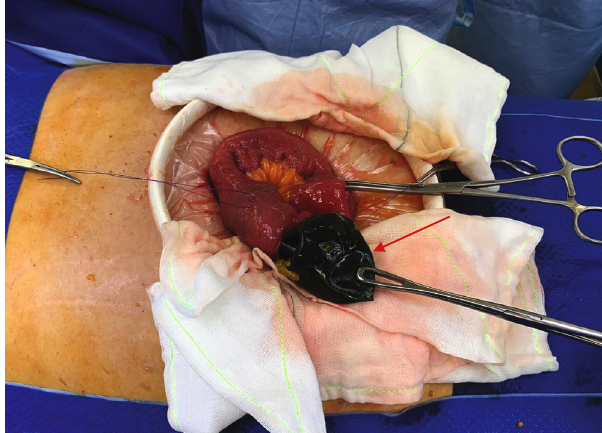
Figure 2: Intraoperative photo of IGB (red arrow) removed from small bowel via enterotomy performed.